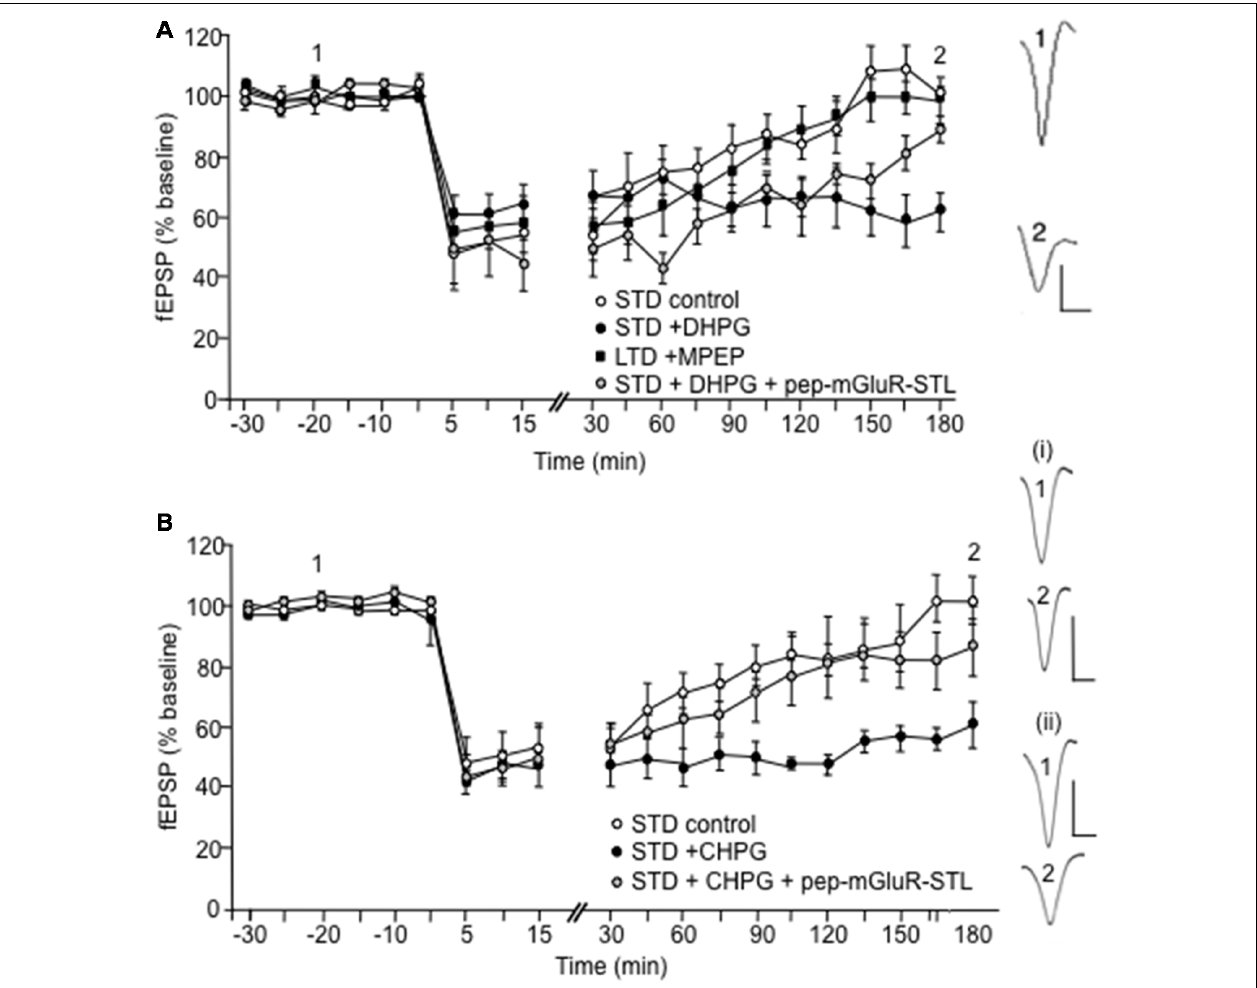
FIGURE 4 | Facilitation of LTD induced by pharmacological activation of group I mGlu receptors is prevented by pep-mGluR-STL. (A) LFS in a frequency of 1 Hz (900 pulses) induces short-term depression (STD) that lasts for up to 3 h in the CA1 region of hippocampal slices from animals that were treated with control peptide ( n = 6). Application of (S)-3,5-Dihydroxyphenylglycine (DHPG; 5 µ M) prior to LFS ( n = 6) facilitates STD into LTD. The facilitating effect of DHPG on LTD is prevented by prior treatment of animals with pep-mGluR-STL (25 µ g, n = 6). Induction of LTD that lasts for longer than 3 h by stronger LFS (2 Hz, 1,200 pulses) is prevented in hippocampal slices from by the mGlu5 receptor antagonist, MPEP (40 µ M, n = 6). Analogs to the right of the graph represent responses elicited in the presence of DHPG in blocking peptide-treated hippocampi at the time-points noted. Vertical bar: 1 mV, Horizontal bar: 10 ms. (B) Application of (R,S)-2-chloro-5-Hydroxyphenylglycine (CHPG; 100 µ M) prior to LFS (1 Hz, 900 pulses, n = 8) facilitates STD into LTD, compared to controls ( n = 7) The facilitating effect of CHPG on LTD of hippocampal slices from is prevented by prior treatment of animals with pep-mGluR-STL (25 µ g, n = 8). Line-breaks indicate changes in time-scale. Analogs to the right of the graph represent responses elicited in the presence of: (i) CHPG in blocking peptide-treated hippocampi; and (ii) CHPG in control peptide-treated hippocampi at the time-points noted. Vertical bar: 1 mV, Horizontal bar: 10